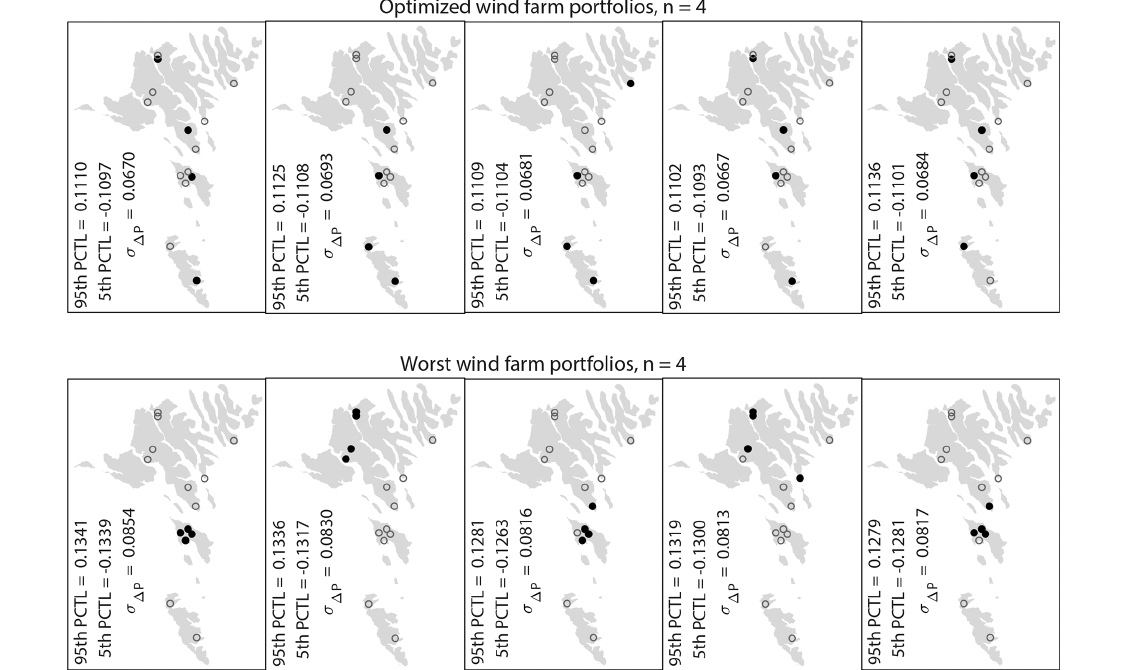
Figure 8. Examples of the optimized (top) and the worst (bottom) wind farm portfolios with four wind farms (black filled circles) where the rated power at each wind farm is the same. The open circles mark the locations that are not selected. These examples are the portfolios with smallest (optimized portfolios) and largest (worst portfolios) integrals of the PSD with respect to frequencies from (3h) − 1 to (2h) − 1 out of all possible combinations of four wind farms. The 5th and 95th percentiles (PCTL) and the standard deviation of the hourly step-change function of the total wind power time series per installed power are given in the bottom left corner of each example.